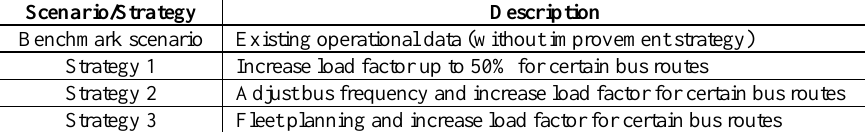
Table 5. The outlines for benchmark scenario and improvement strategies